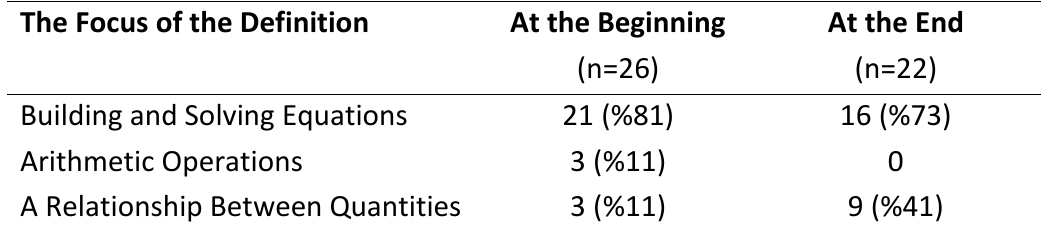
At the End (n=26) (n=22)